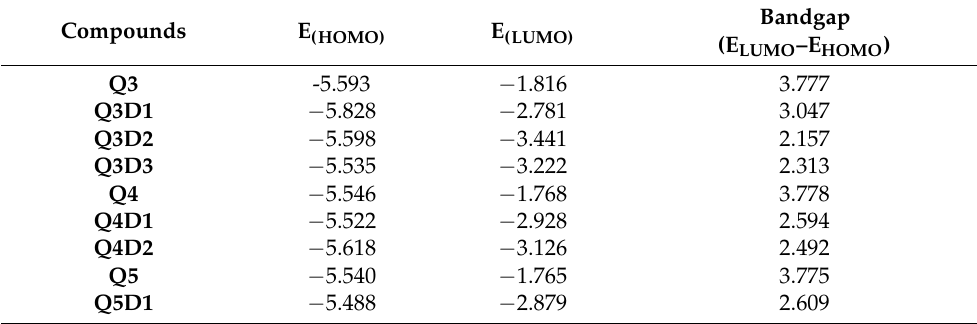
Table 1. E HOMO , E LUMO , and energy gap (E LUMO –E HOMO ) of the investigated compounds in eV using B3LYP/6-311G (d,p) level of